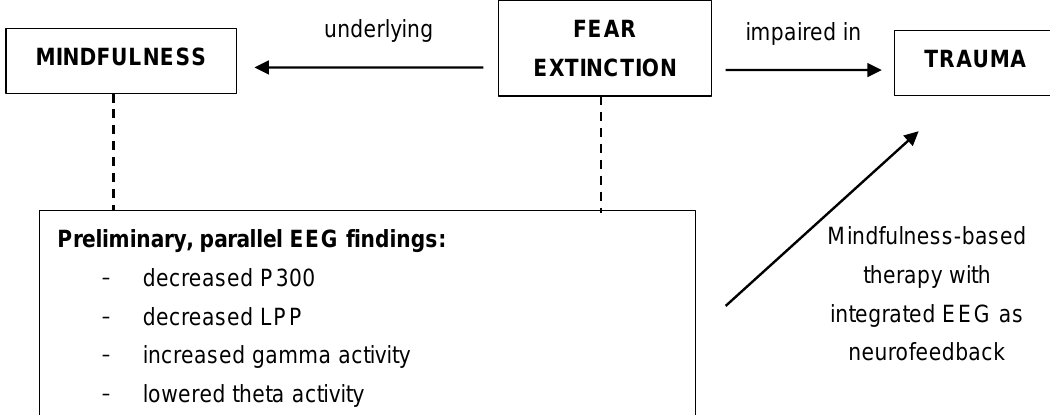
Figure 1. Conceptual connections between mindfulness, fear extinction and trauma, and the suggested implications of electroencephalogram (EEG) as neuromarkers in trauma treatments. LPP—late positive potentials.